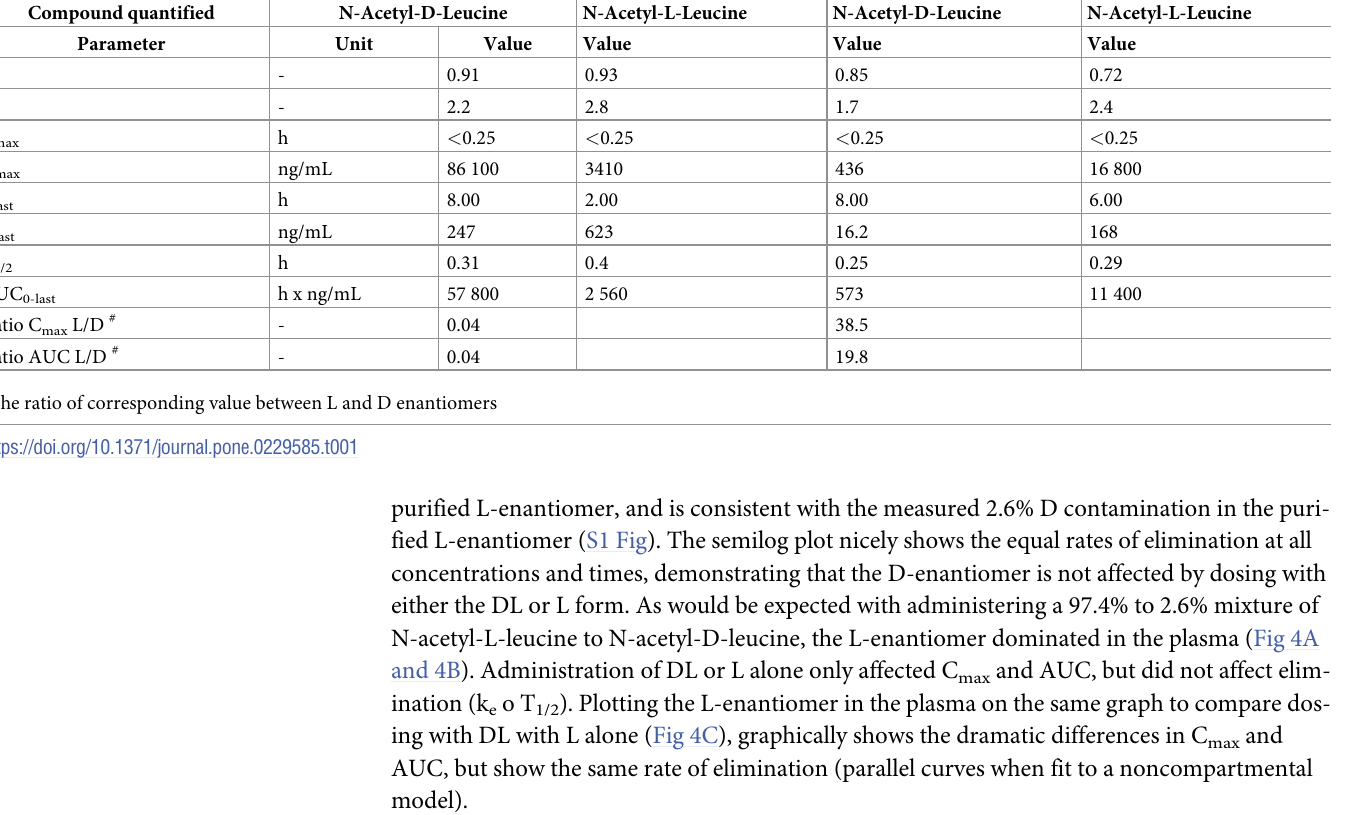
Table 1. The calculated pharmacokinetic parameters for N-Acetyl-D-Leucine and N-Acetyl-L-Leucine plasma after oral administration of N-Acetyl-DL-Leucine or N-Acetyl-L-Leucine at a nominal dose of 100 mg/kg. Compound